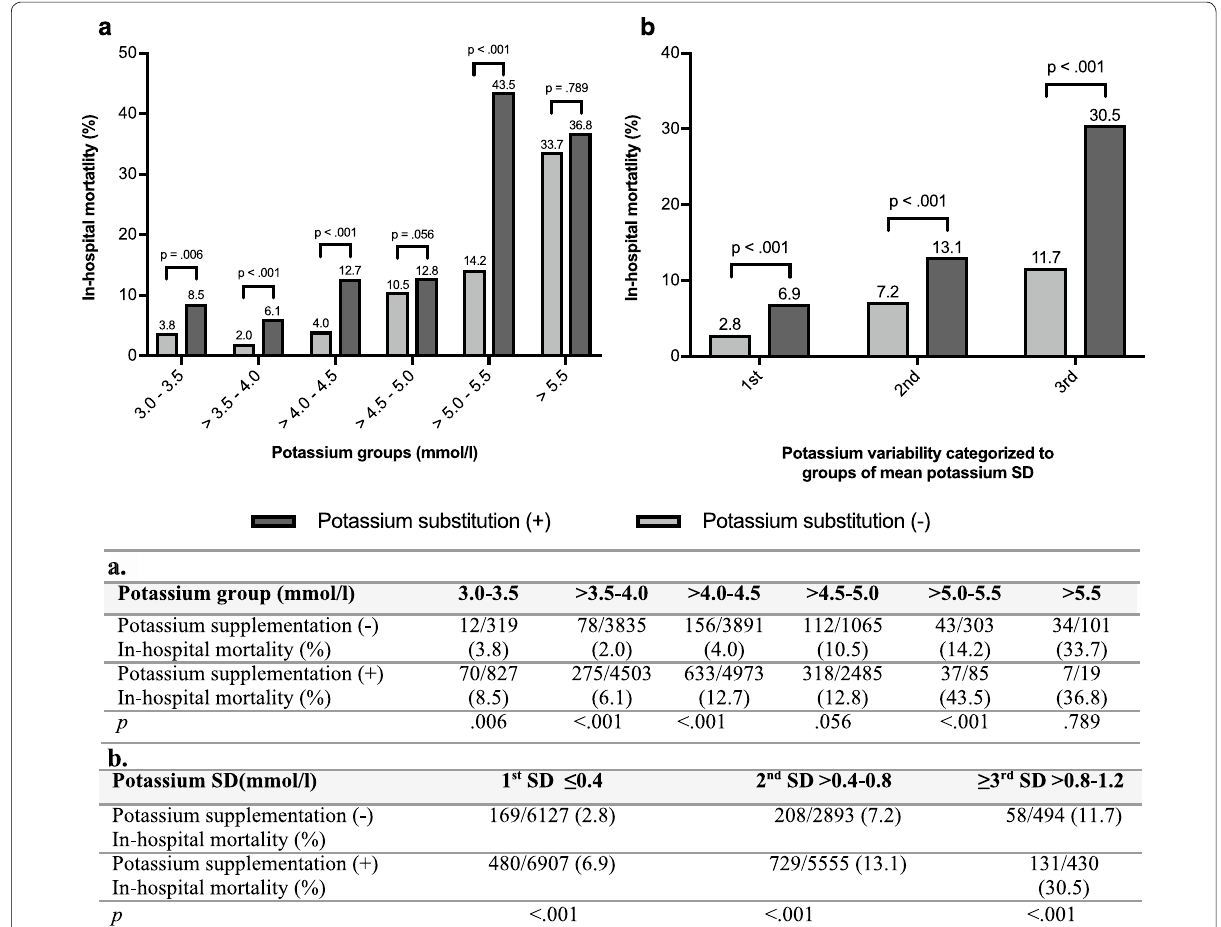
Fig. 4 Association between potassium supplementation and in‑hospital mortality, n number of patients in groups of ( a ) mean potassium concentration and ( b ) potassium variability. ( ( ) patients did not receive potassium supplementation. p values determined by χ 2 −